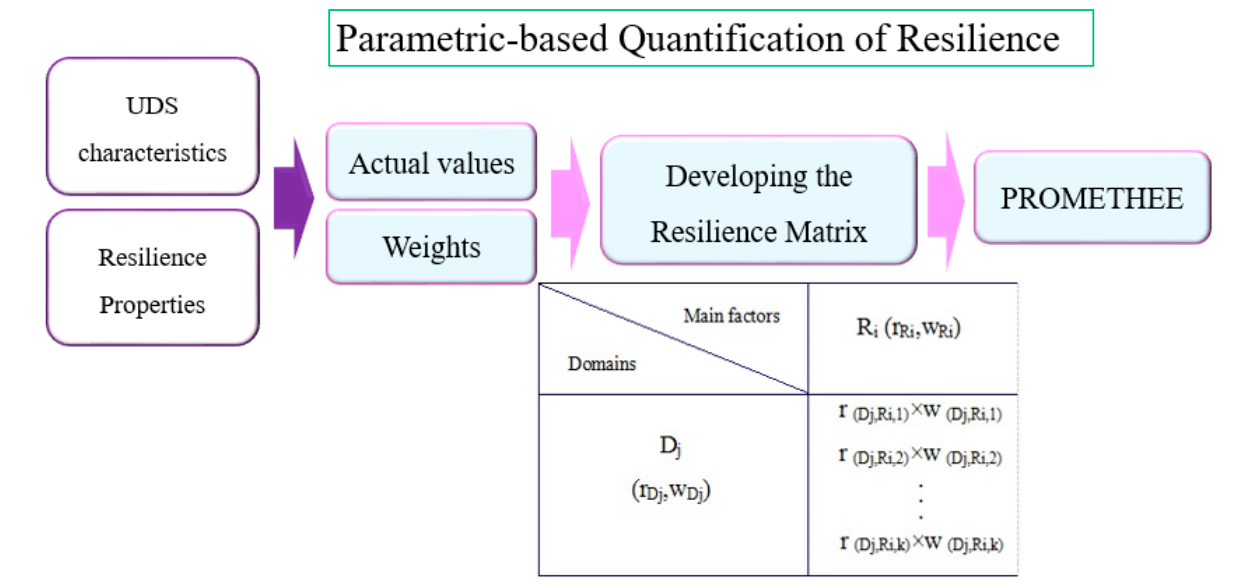
Figure 5. The flowchart of resilience quantification in a parametric-based method.